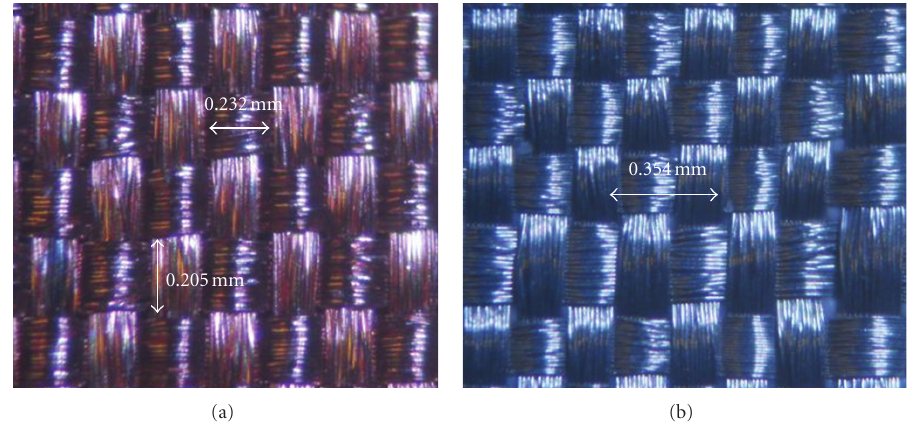
Figure 6: Microphotographs of (a) Pure Cooper Ta ff eta Fabric. (b) Schieldit Super.